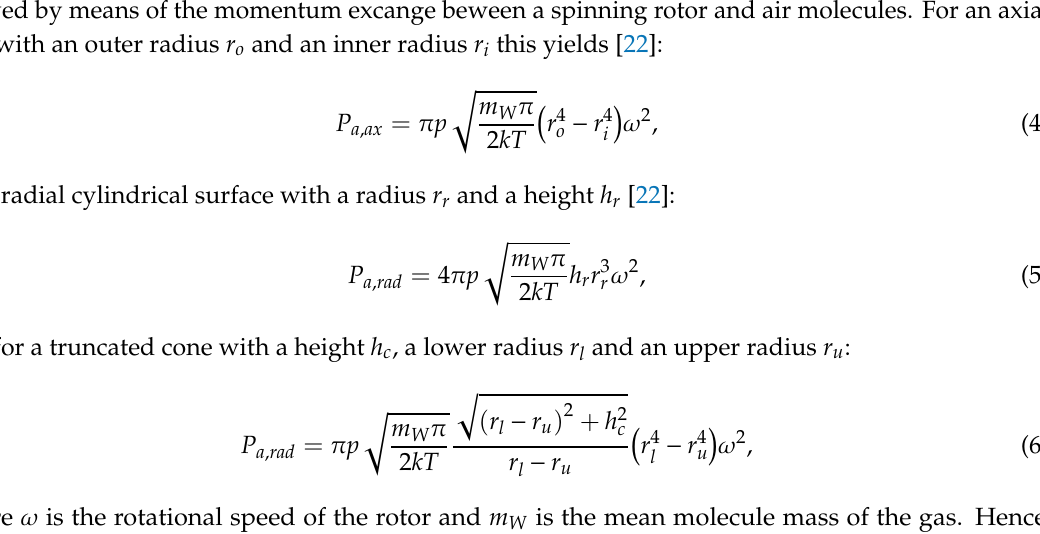
Table 2. Air friction losses in the test rig with 𝑝 (cid:3404) 0.05 Pa and 𝑇 (cid:3404) 290 K .